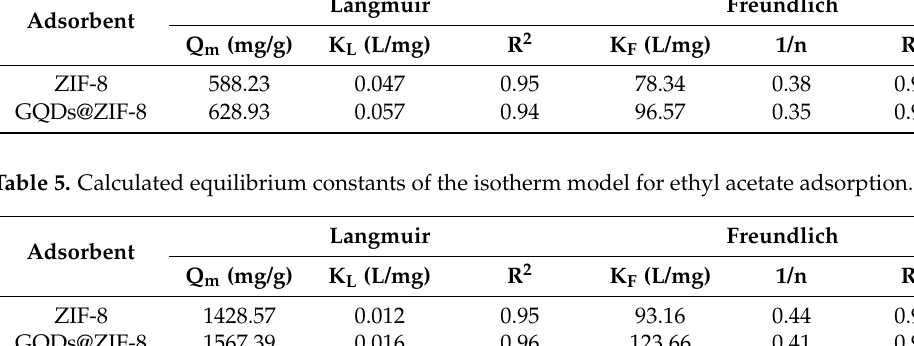
Table 4. Calculated equilibrium constants of the isotherm model for toluene adsorption. Langmuir Freundlich Adsorbent